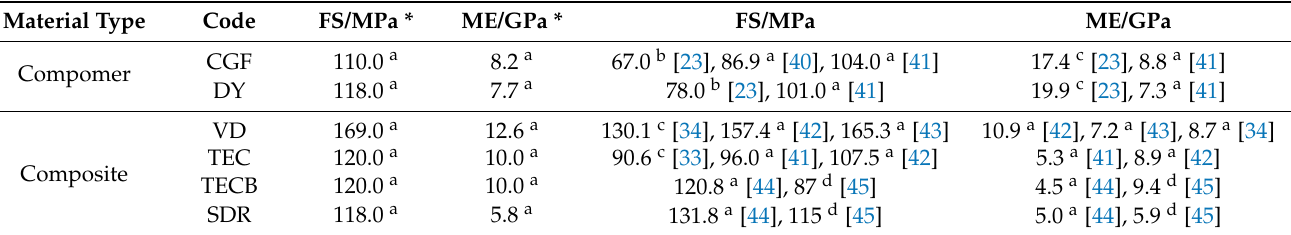
Table 2. Mechanical properties of tested materials (selected literature